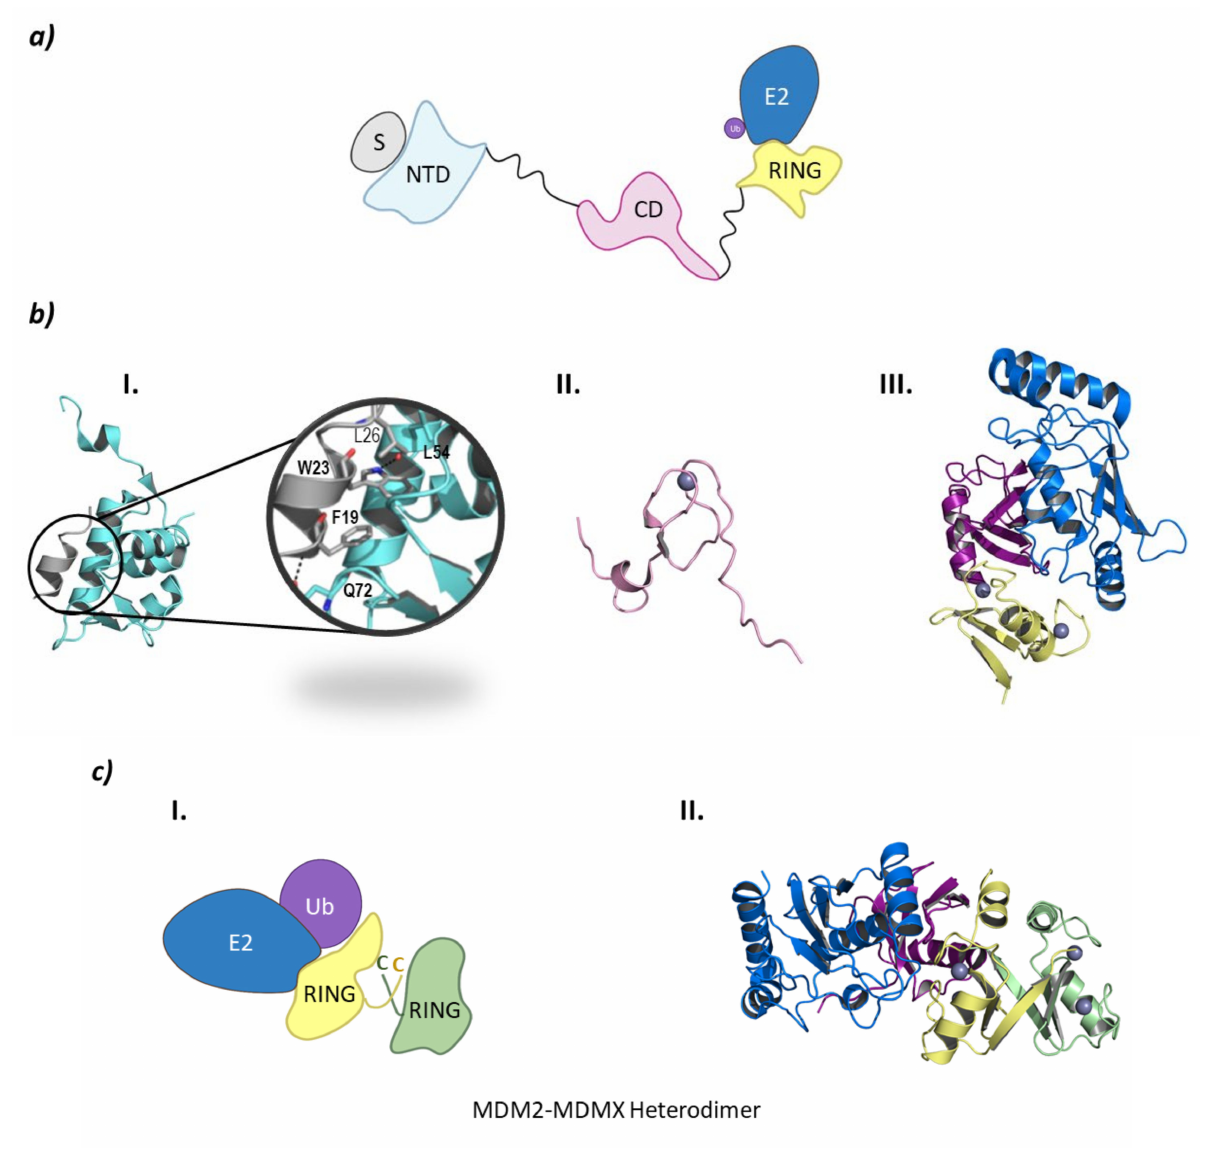
Figure 10. MDM. ( a ) Schematic representation of the assembly of a monomer of the MDM E3 ligase: ubiquitin (Ub) in purple, E2 ligase (E2) in dark blue, Ring domain (RING) in yellow, central domain (CD) in pink, N -terminal domain (NTD) in light blue, and substrate protein in grey. ( b ) Protein assembly I is the PyMOL stick and cartoon representation of the NTD of MDM in complex with a small α -helix of the p53 oncosuppressor protein as found in PDB code 4HFZ. Protein assembly II is the 3D representation of the CD as found in PDB code 2C6A. Protein assembly III is the 3D representation of the RING domain in complex with E2 ligase UbcH5B bound to ubiquitin as found in PDB code 7AI1. ( c ) I is the schematic representation of the assembly of the heterodimeric assembly of MDM2/MDMX E3 ligases: ubiquitin (Ub) in purple, E2 ligase (E2) in dark blue, Ring domain (RING) of MDM2 in yellow, RING domain (RING) of MDMX in green, central domain (CD) in pink, N -terminal domain (NTD) in light blue, and substrate protein in grey. Protein assembly II is the 3D representation of the heterodimeric assembly of MDM2/MDMX as found in PDB code